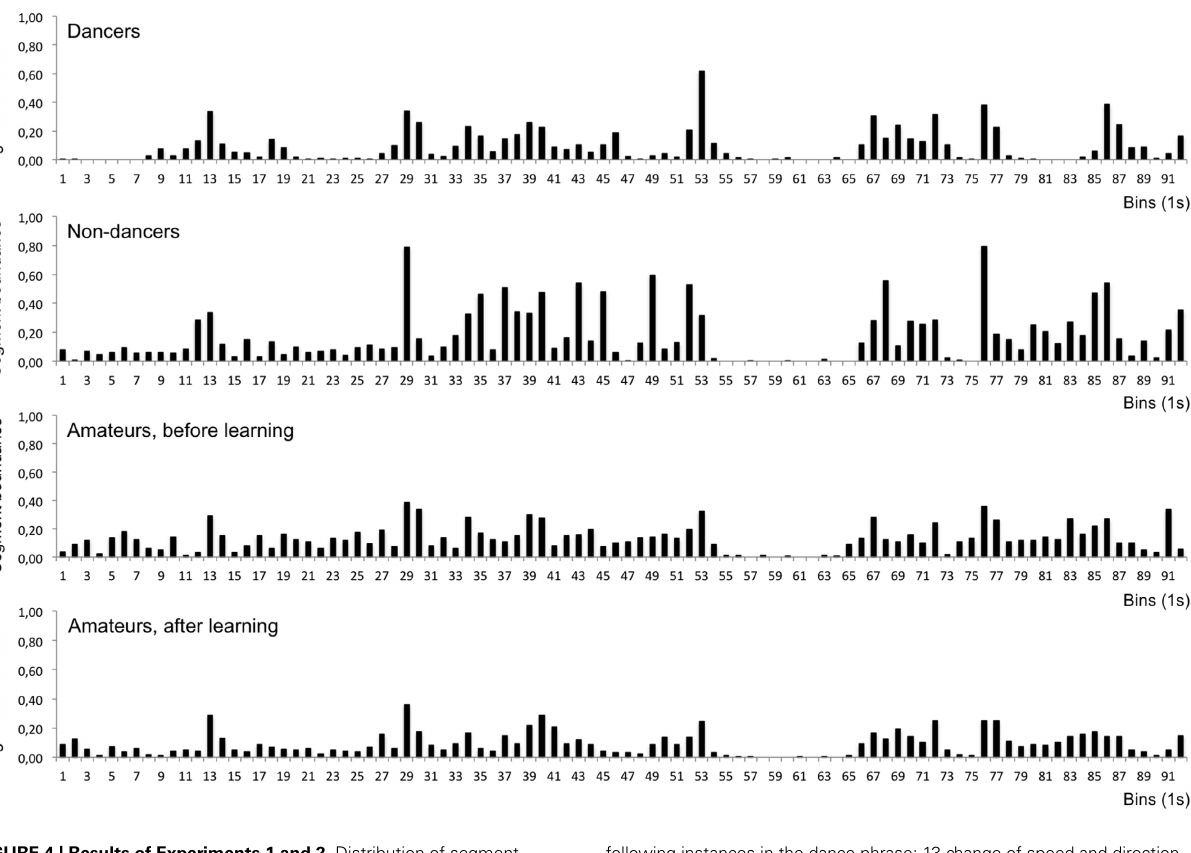
following instances in the dance phrase: 13 change of speed and direction during a floor sequence; 29 slowing down and raising to the knees from floor sequence; 53 slowing down floor movement, raising into shoulder stand; 76 transition from walking to dynamic swinging movement initiated by an impulse of the right shoulder; 86 going down to the floor from